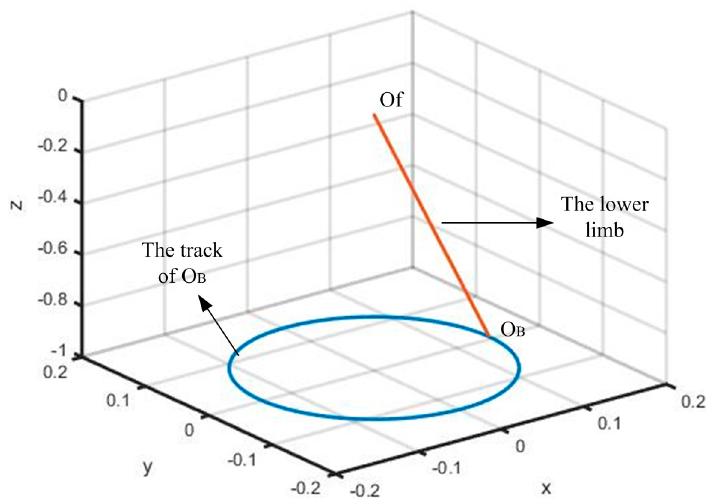
Figure 9. The track of the standing platform.